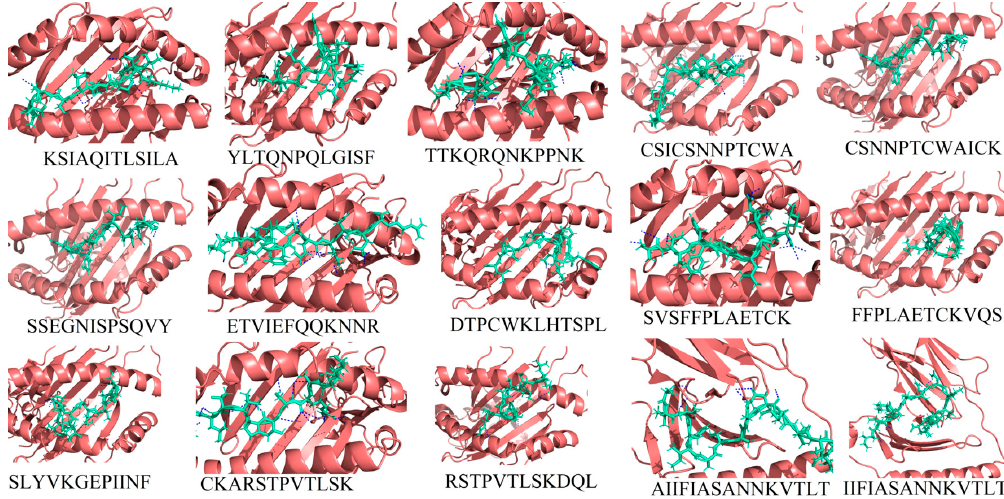
Figure 2. The 3D binding pattern of the selected 15 epitopes (deep-salmon cartoon representation) docked with their respective HLAs (green-cyan sticks representation) as shown in Table 2. Hydrogen bond interactions are highlighted with blue color dotted lines.